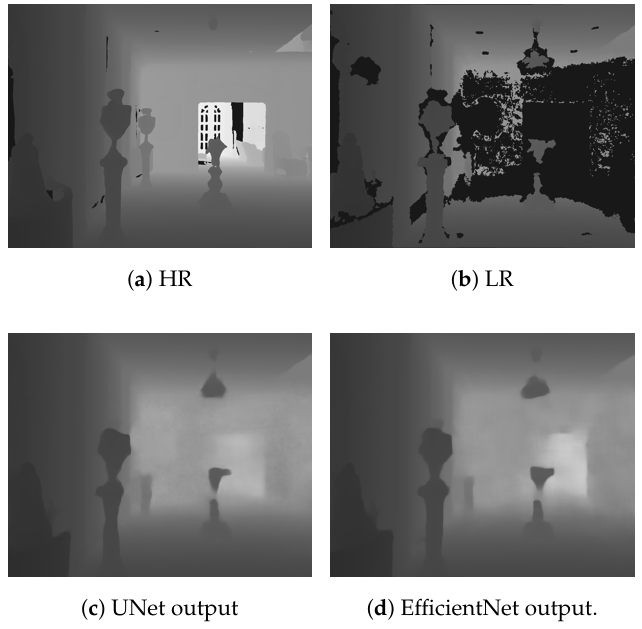
Figure 3. The visual comparison of the depth completion on the Matterport3D dataset [43]. Note that (c) was produced using the Guidance branch based on UNet [26] and (d) was produced using the Guidance branch based on EfficientNet